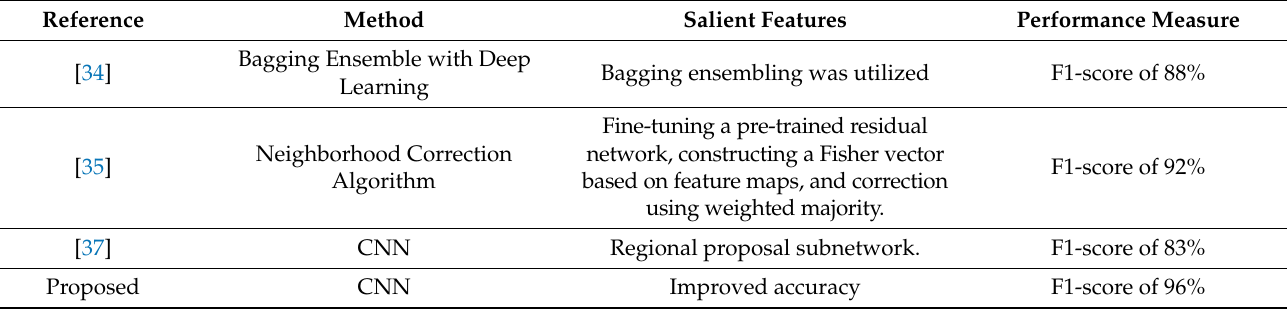
Table 4. Comparison of results on the C_NMC_2019